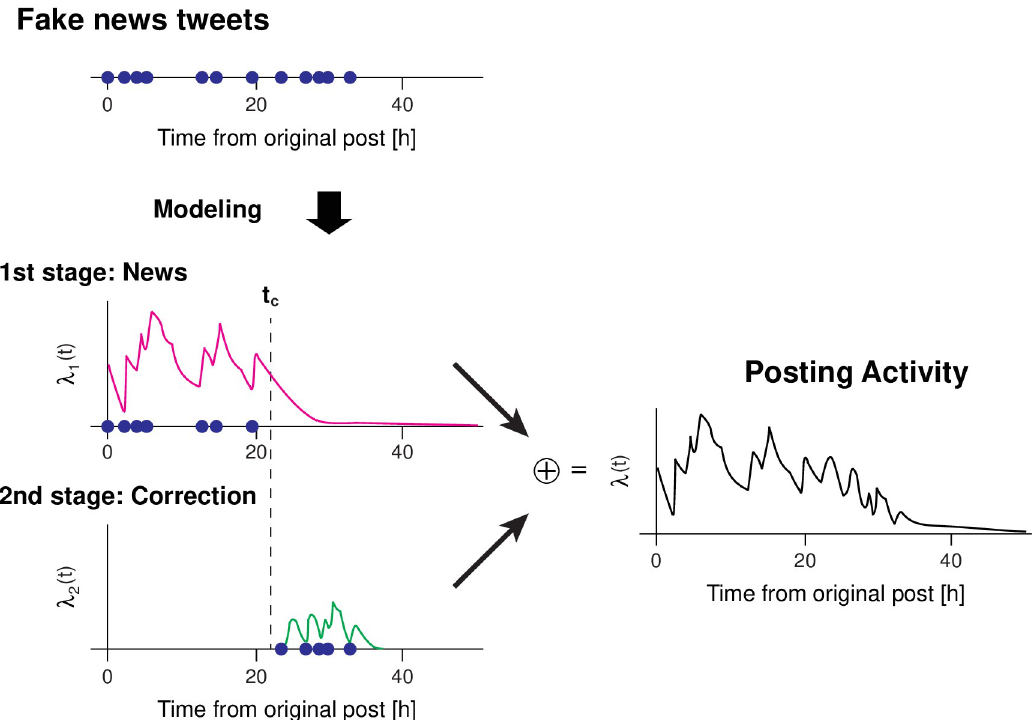
Fig 1. Schematic of the proposed model. We propose a model that describes how posts or re-shares that are related to a fake news item spread on social media (Fake news tweets). Blue circles represent the time stamp of the tweets. The proposed model assumes that the information spread is described as a two-stage process. Initially, a fake news item spreads as a novel news story (1st stage). After a correction time t c , Twitter users recognize the falsity of the news item. Then, the information that the original news item is false spreads as another news story (2nd stage). The posting activity related to the fake news λ ( t ) (right: black) is given by the summation of the activity of the two stages (left: magenta and